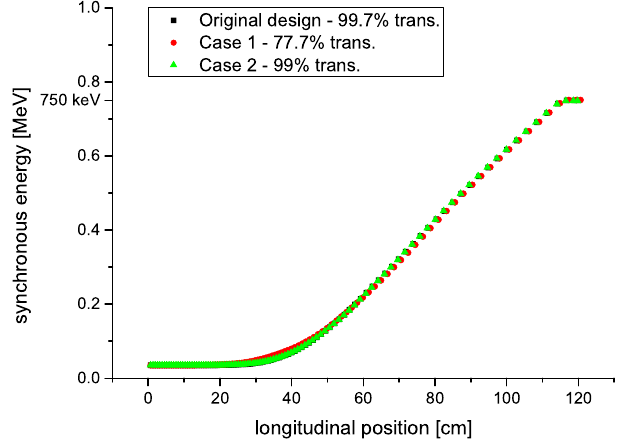
FIG. 15. Parmteq M simulations: the radial displacement of the electrodes has no significant influence on the output energy of the RFQ. The displaced mid-section of the RFQ electrodes (case 1), where the bunching takes place, reduces the transmission from 99.7%to77.7%.Whileadisplacementatbothendsoftheelectrodes (case 2) leads to a minor reduction in transmission by